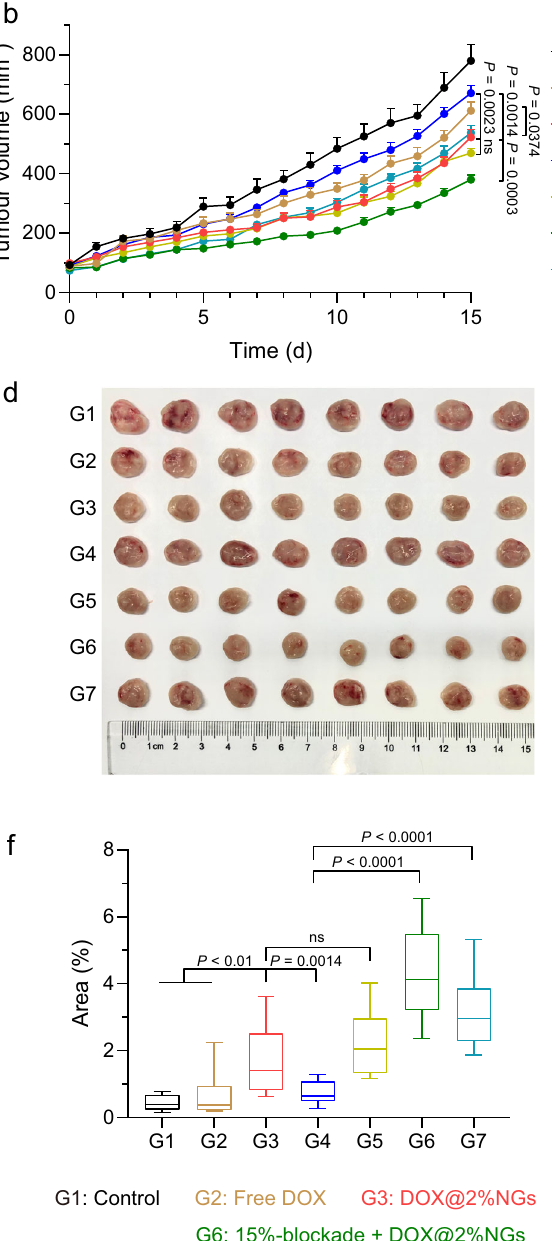
treatment. Data are presented as mean values±SD ( n =8 biological independent replicates).Percentageoftheareaof( f) apoptoticcellsand( g) proliferatecells.Box plots indicate median (middle line), 25th, 75th percentile (box) and minimum and maximum (whiskers) ( n =15 independent replicates). Statistical signi fi cance was calculated by unpaired two-sided Student ’ s t test. G1, Control; G2, Free DOX; G3, DOX@2%NGs; G4, DOX@15%NGs; G5, 2%-blockade+DOX@2%NGs; G6, 15%- blockade+DOX@2%NGs; G7, 15%-blockade+DOX@15%NGs. Source data are provided as a Source Data fi